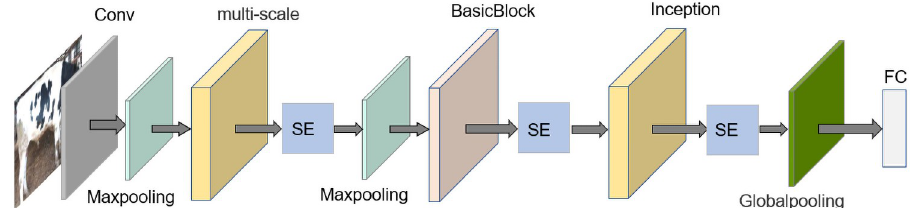
Fig 5. Structure of the model used in this